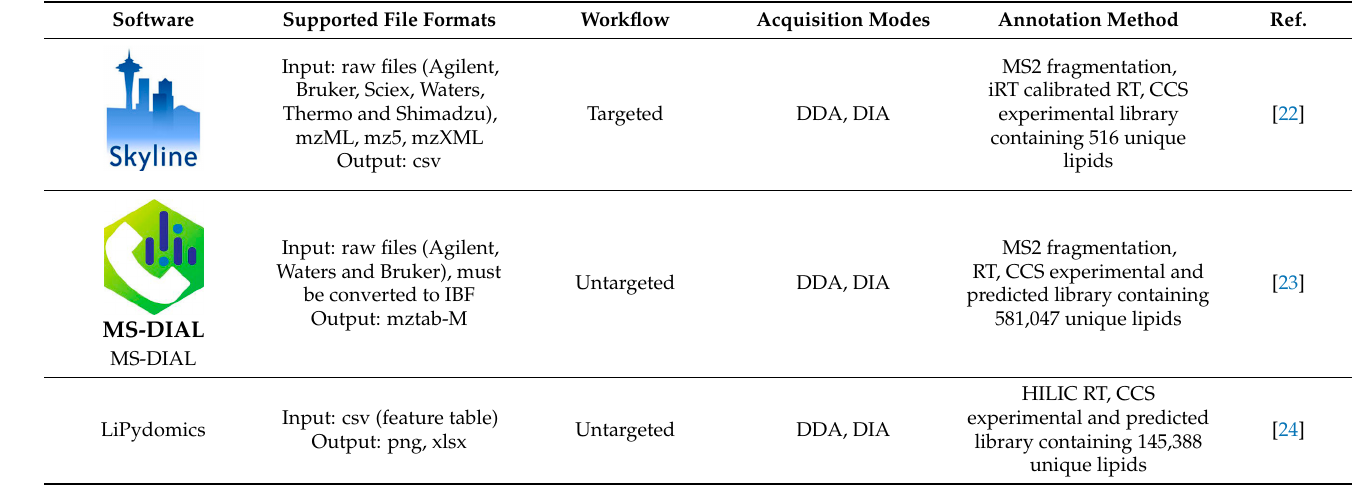
Table 1. Survey of software tools for analysis of IMS-based lipidomics data. Abbreviations: DIA, data-independent acquisition; DDA, data-dependent acquisition; MS1, normal MS (without frag- mentation); MS2, tandem MS/MS (includes fragmentation); RT, retention time; CCS, collision cross section; HILIC, hydrophilic interaction chromatography; NA, not applicable.